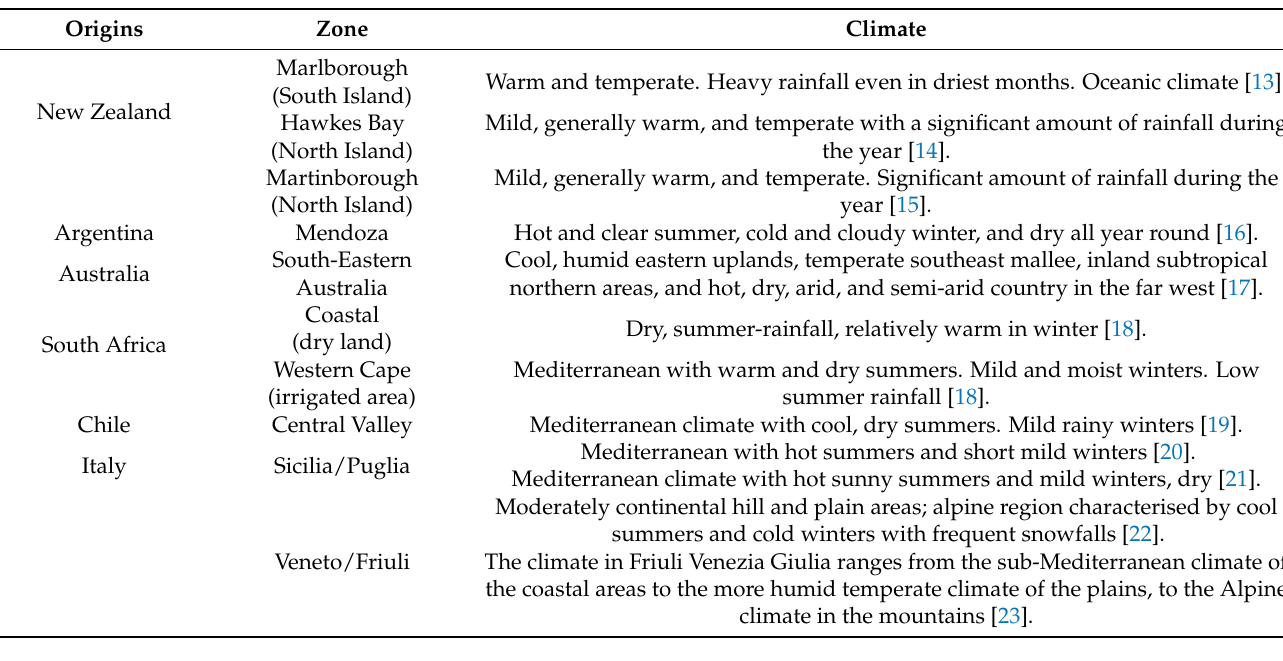
Table 3. Climate details for the different origins of the